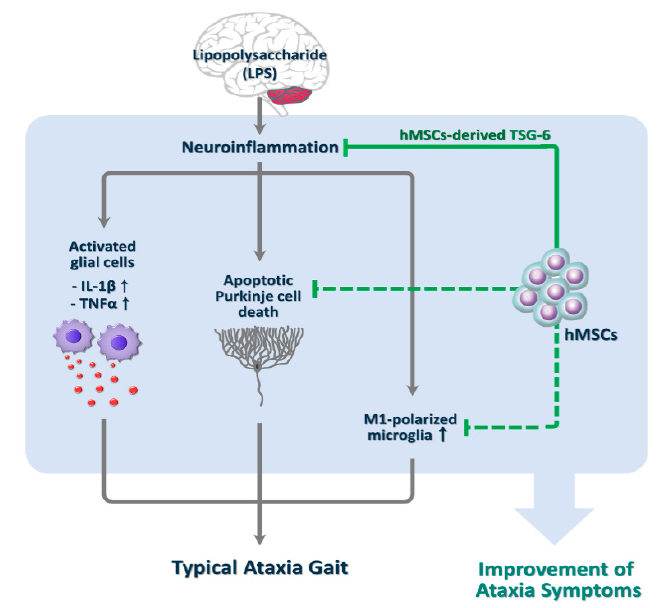
Figure 6. Schematic for the beneficial effects of hMSCs in the LPS-induced ICA mice. Intercerebellar LPS administration in experimental animals may be useful to study the phenotypes of ICA, and hMSCs may have therapeutic effects though the inhibition of neurotoxic inflammation, M1-type microglial polarization, and apoptotic Purkinje cell death against ICA, resulting in the improvement of ataxia symptoms. hMSCs, human mesenchymal stem cells; ICA, inflammatory cerebellar ataxias. Supplementary Materials: The following are available online at www.mdpi.com/xxx/s1, Figure S1: TSG-6 upregulation in the LPS-exposed cerebellum.